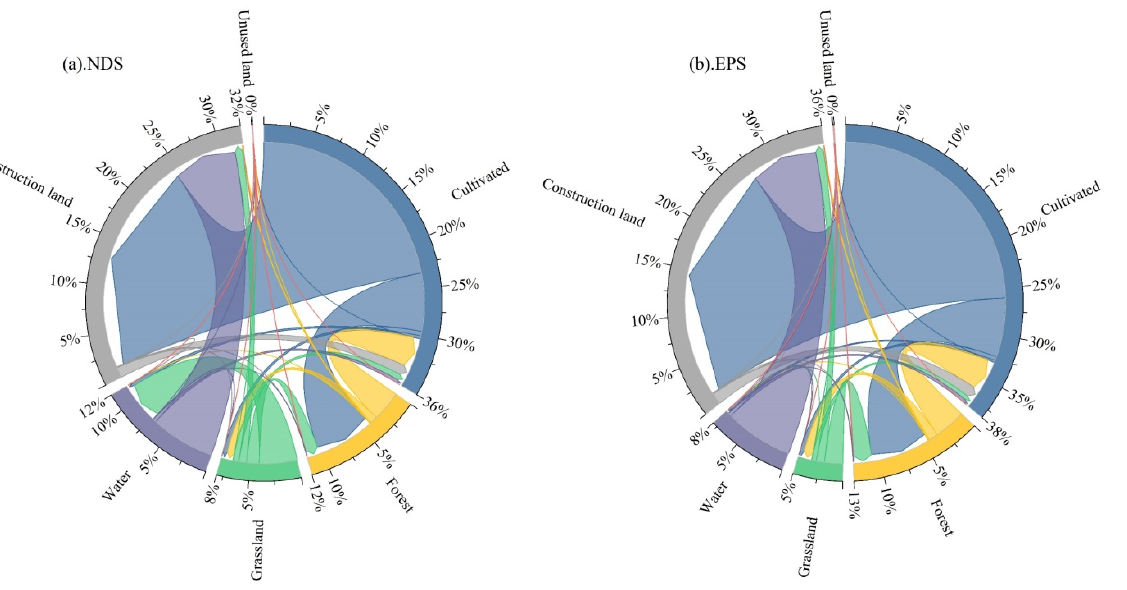
Figure 3. Chord diagram of land-use